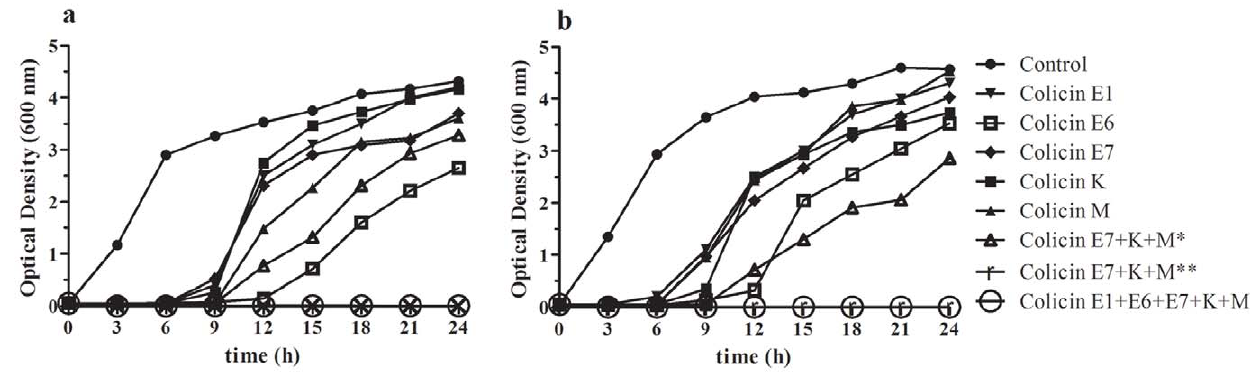
Figure 2. Effect of colicins on uroseptic strains. Effect of colicins E1, E6, E7, K and M on uroseptic strains UL209 (a) and UL141 (b). All colicins were added to the final concentration 1 m g/ml. Control represents the bacterial culture without colicin. * colicins were applied only at the beginning of the growth cycle; ** colicins were applied throughout the growth cycle.